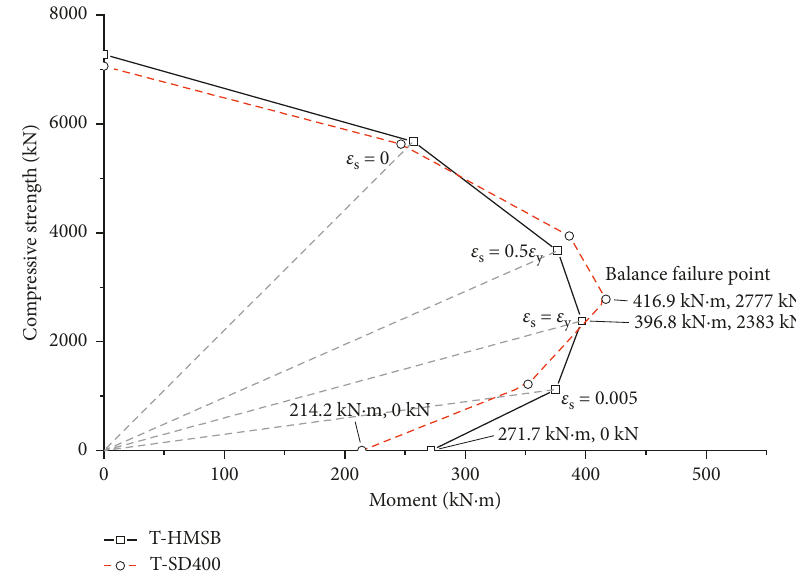
Figure 6: Theoretical P - M interaction curves for T-SD400 and T-HMSB specimens.